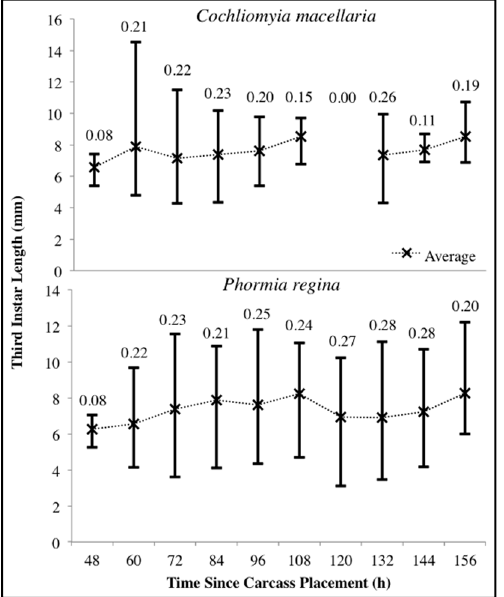
Figure 6: Range of Cochliomyia macellaria and Phormia regina third instar body length throughout decomposition. Upper and lower limits represent the maximum and minimum lengths, respectively.